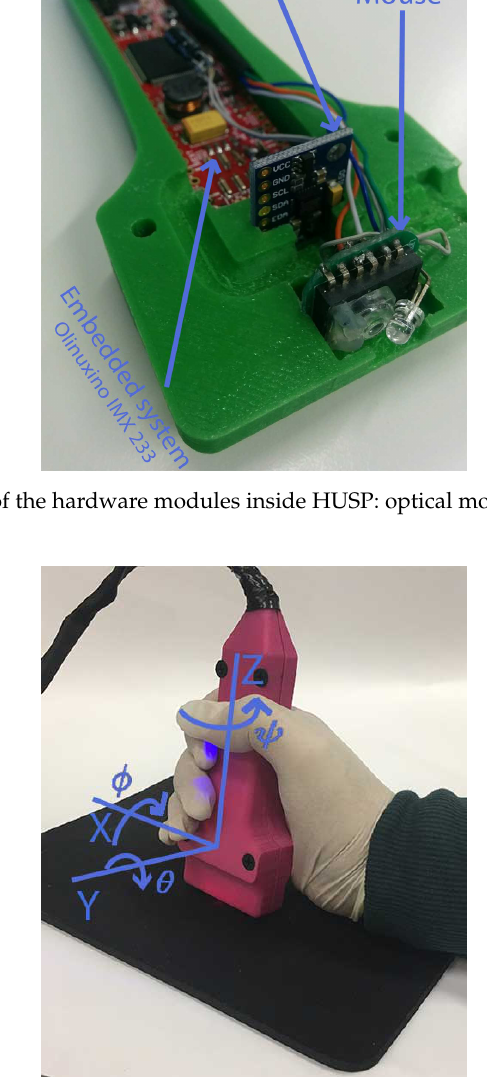
Figure 2. Rotation movements of the probe in the hand of a specialist and body